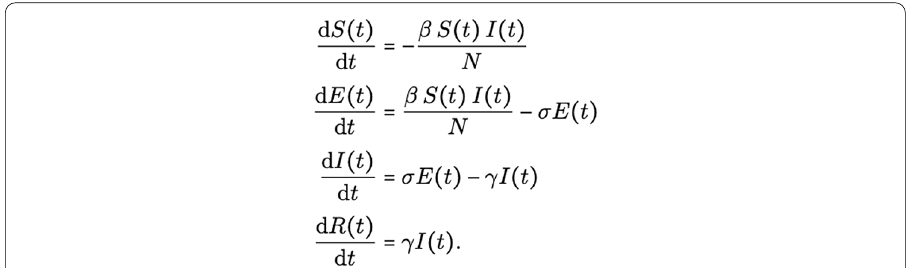
Fig. 18 SEIR differential equations (Image taken from Dandekar and Barbastathis